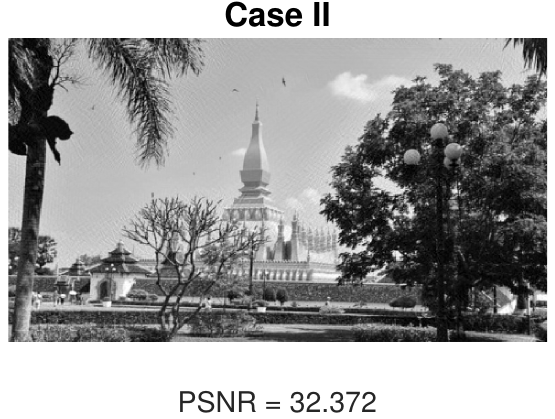
Figure 22. The reconstructed grey image with their PSNRs for three different cases using the proposed algorithm presented in 10,000 iterations, respectively.